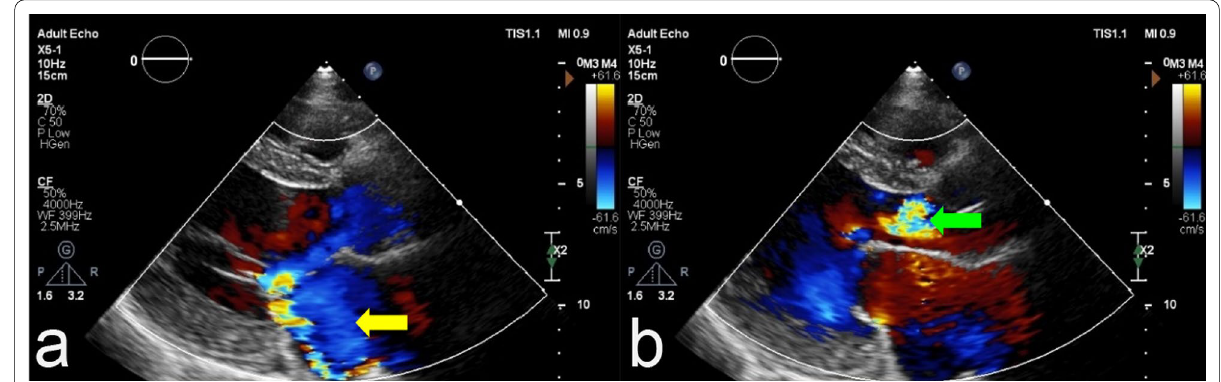
Fig. 1 Echocardiogram showed left atrial and ventricular dilatation with severe a mitral valve regurgitation (yellow arrow) and b aortic valve regurgitation (green